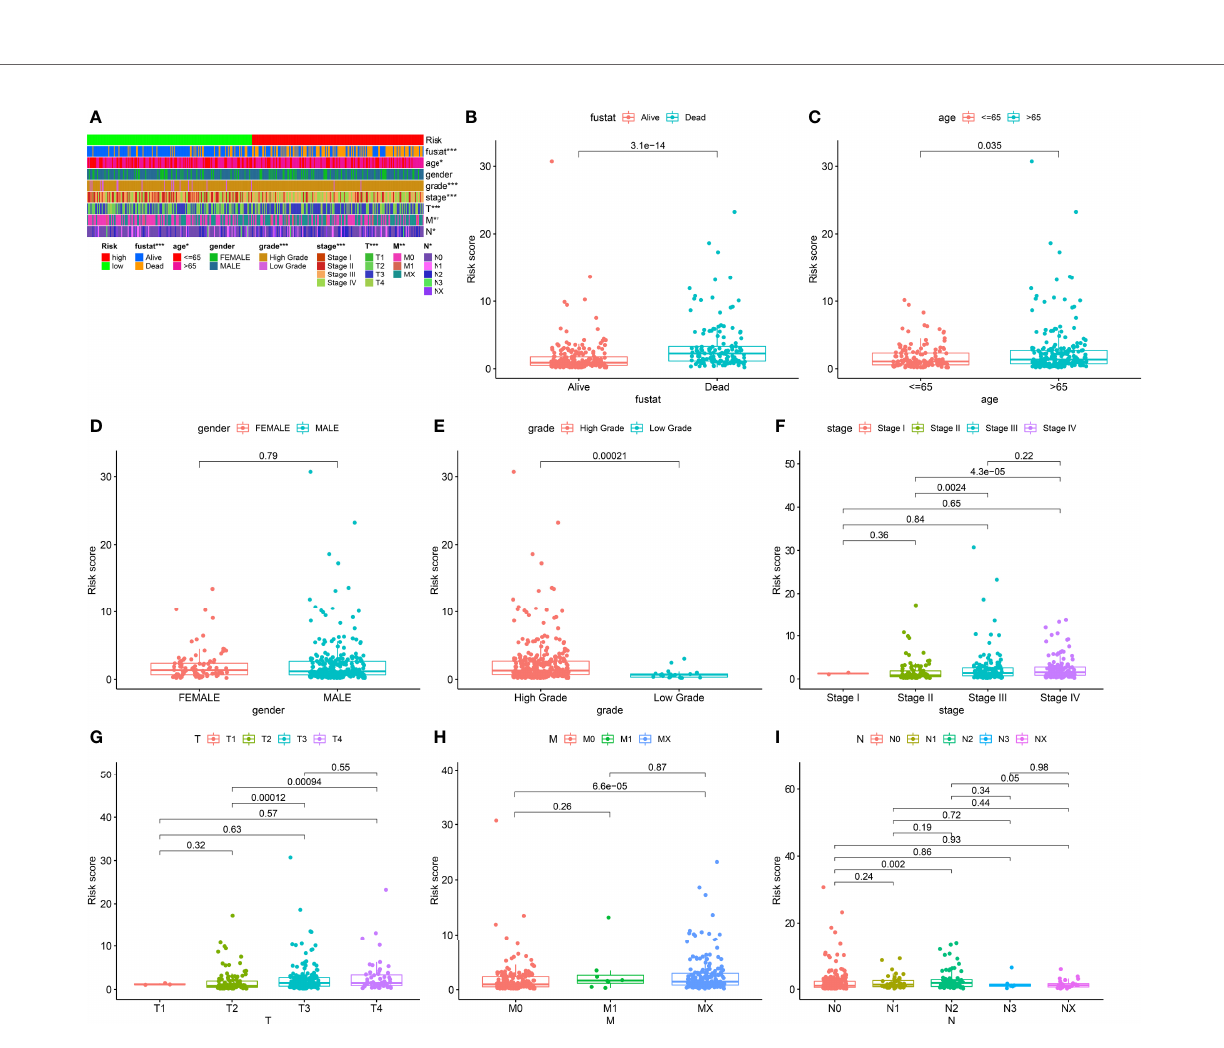
FIGURE 5 | Clinical evaluation of risk models. (A) Heatmap of clinicopathological features. (B) Survival status. (C) Age. (D) Gender. (E) Grade. (F) Clinical stage. (G) T stage. (H) M stage. (I) N stage. *p < 0.05; **p < 0.01; ***p <